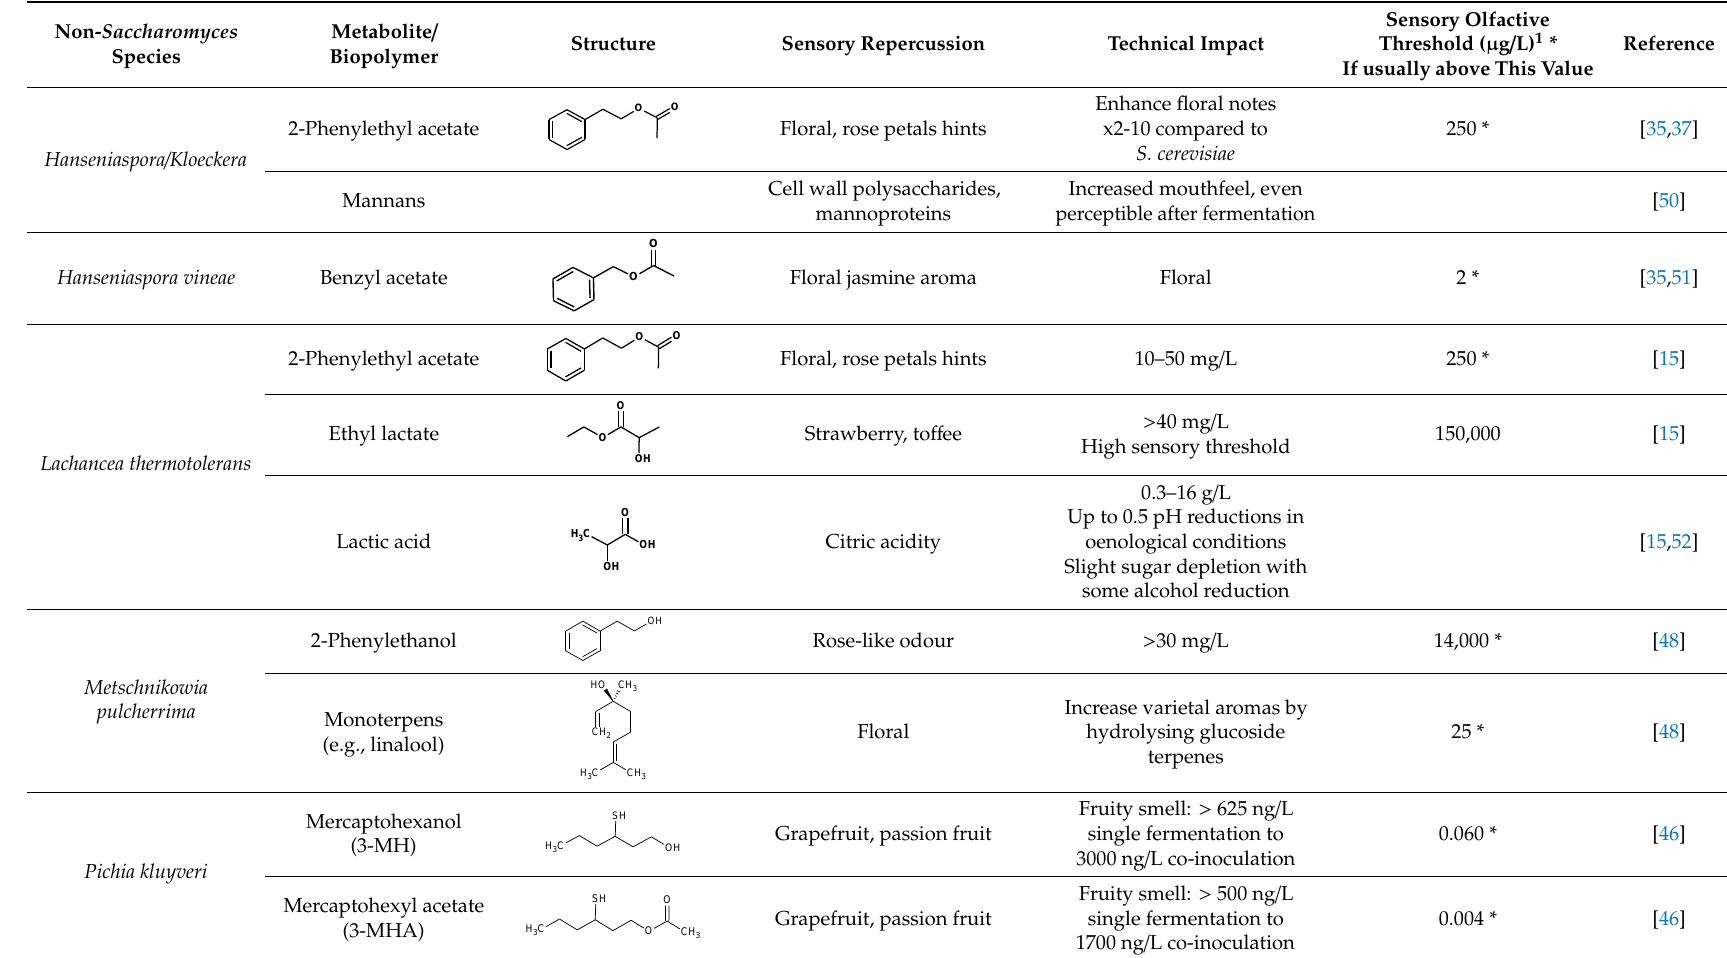
Table 1. Main metabolites of non- Saccharomyces yeasts, sensory repercussion and technical impact.